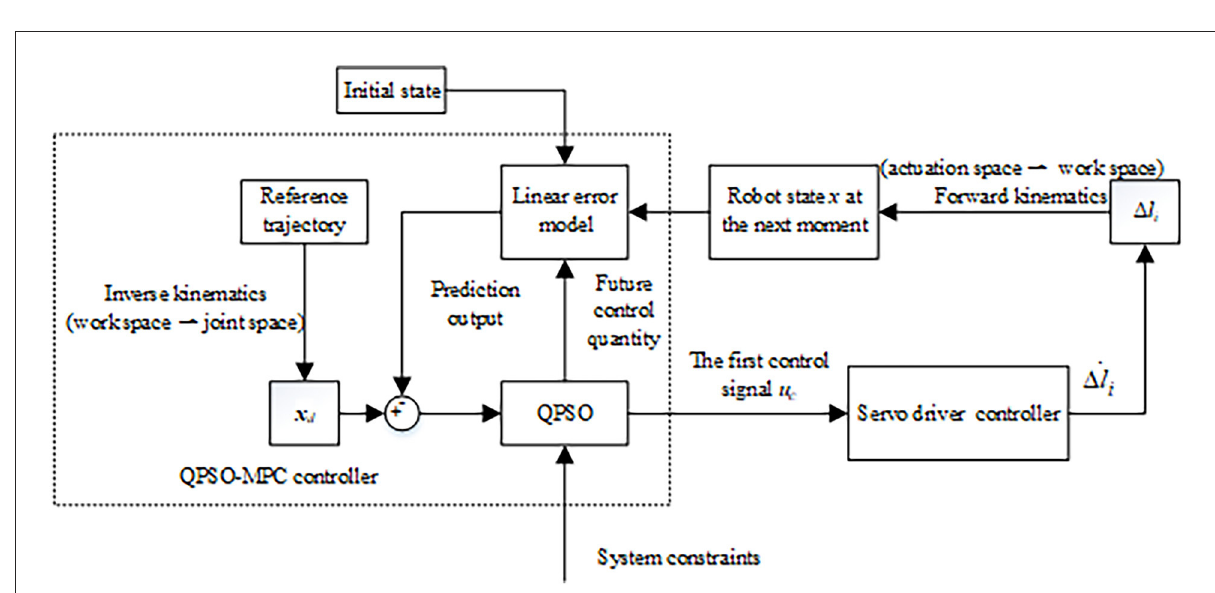
FIGURE3 The block diagram of the trajectory tracking controller based on QPSO-MPC.